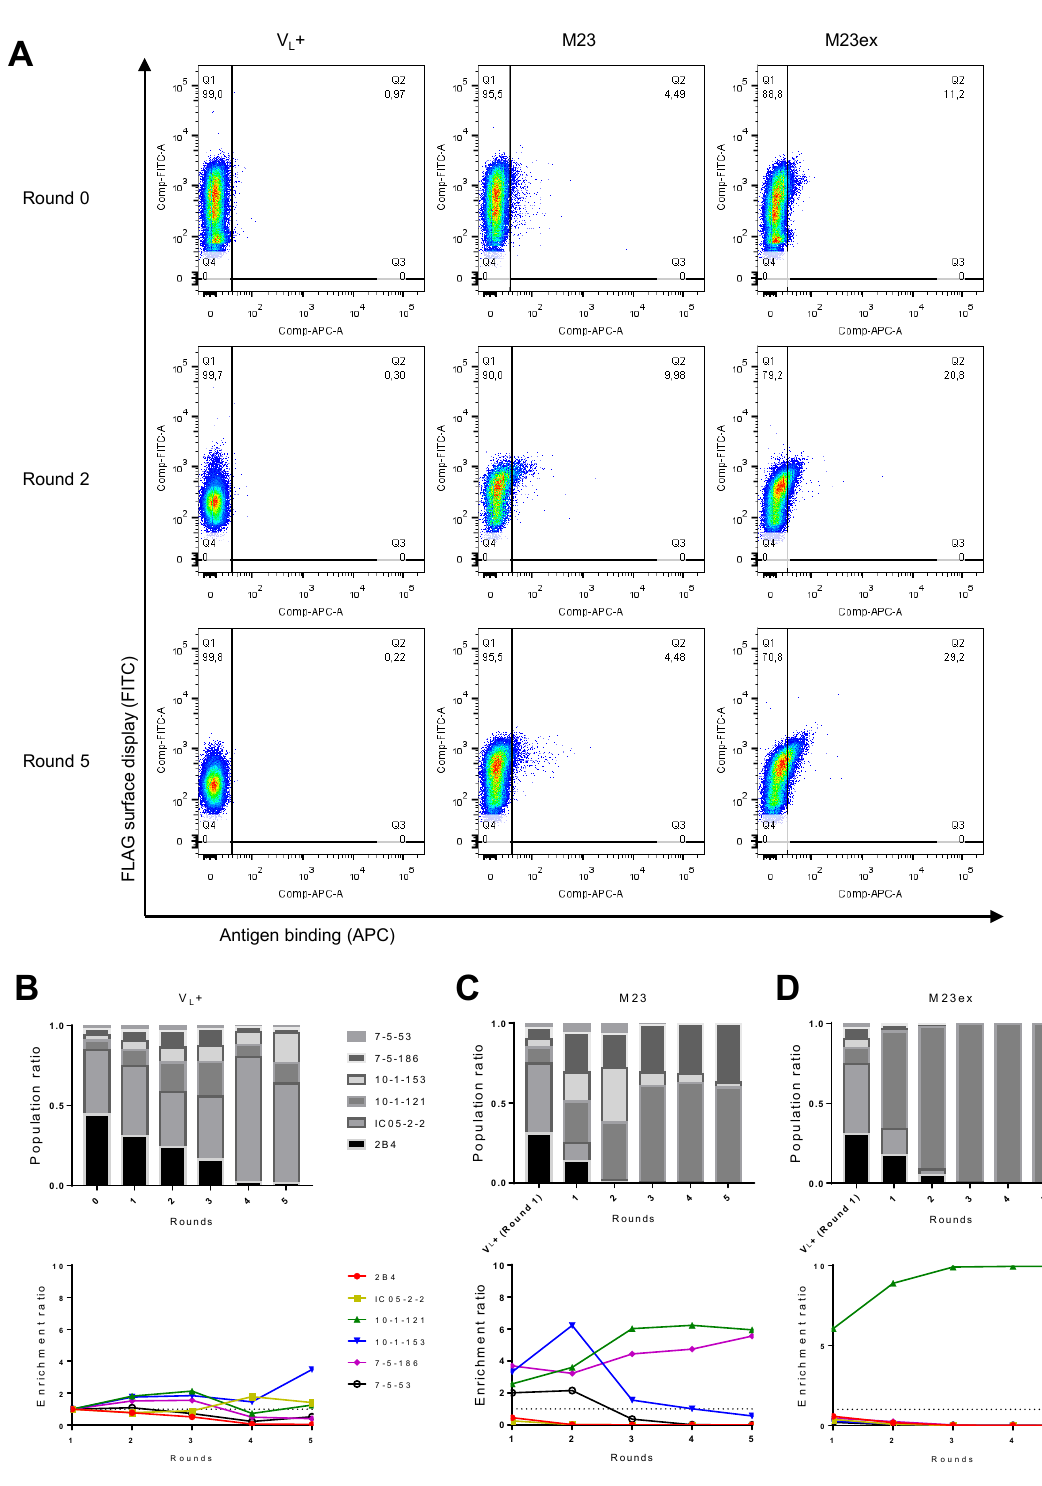
Figure 3. Soluble antigen FACS results. ( A ) FACS plot of sorting for V L + control, and M23 and M23ex soluble antigen binders during Round 0 (i.e., pre-sort), Round 2, and Round 5. After each round of FACS enrichment, NGS was performed to assess the population ratio and enrichment ratio of the monoclonal yeast clones for the ( B ) V L + control, and FACS enrichment with ( C ) M23, or ( D ) M23ex soluble antigen. For the V L + control, the yeast library was selected for the yeast that displayed Fab determined by the expression of the FLAG